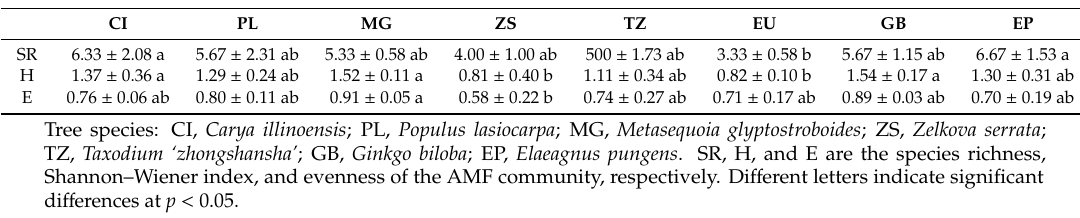
Table 3. Diversity indices of AMF communities in the rhizosphere soils of trees.